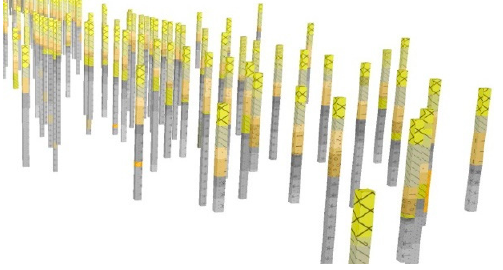
Figure 39. Three-dimensional boreholes.